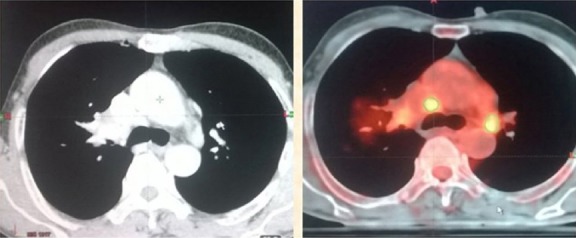
GTV lymph node volume drawn in red on CECT and green on 18F-FDG PET-CT showing increase in GTV volume on18F-FDG PET-CT